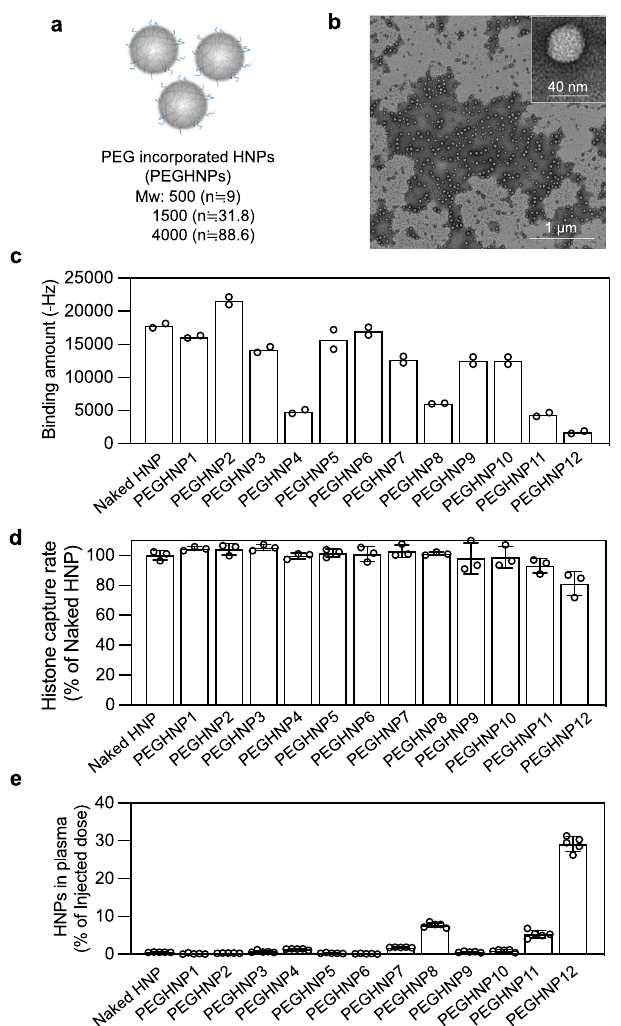
Fig. 3 Incorporation of the optimum amount of PEG into HNPs for increasing the circulation time of HNPs without histone af fi nity reduction. a Schematic of PEGHNPs synthesized by free-radical copolymerization of functional monomers. b TEM image of PEGHNPs. The experiment was repeated two times, fi ve pictures were taken in each experiment. c QCM analysis of the histone – PEGHNP interaction. The surface of the QCM cell was functionalized with histones and solutions of PEGHNPs were added to the QCM cells. Data represent the means of independent duplicate measurements. d Histone capture rate of PEGHNPs.